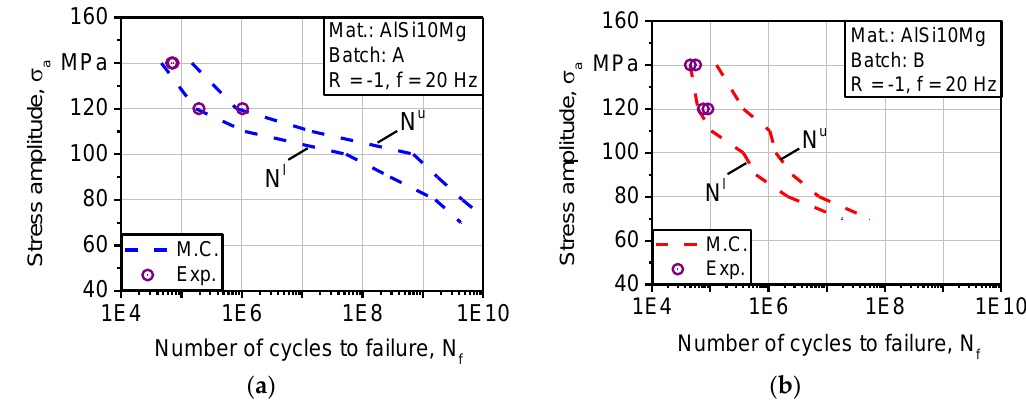
Figure 13. Specimen response of resonance testing for batch D (Scalmalloy ® SLM): ( a ) Change in resonance frequency; ( b ) Total mean strain.